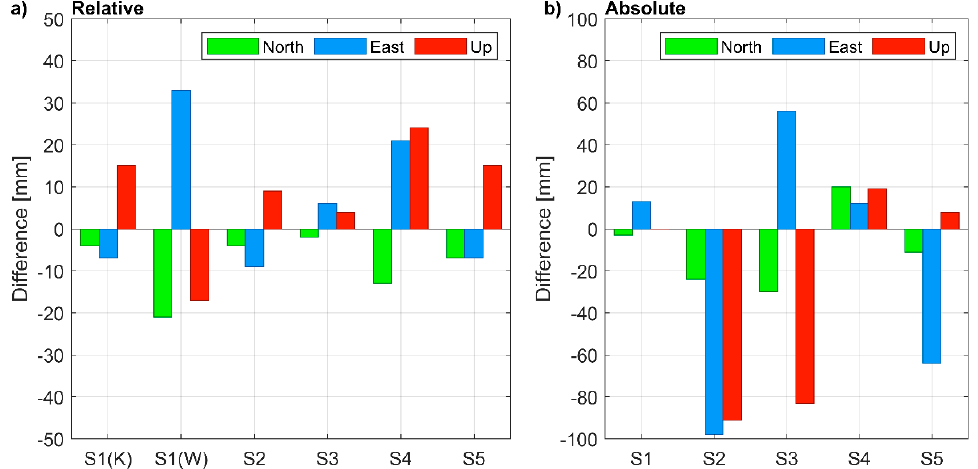
Figure 7. Coordinate differences from 1-h long sessions obtained in: ( a ) relative positioning (the reference station is: KALI for S1(K), WIEL for S1(W), WROC for S2 to S5); ( b ) absolute positioning.